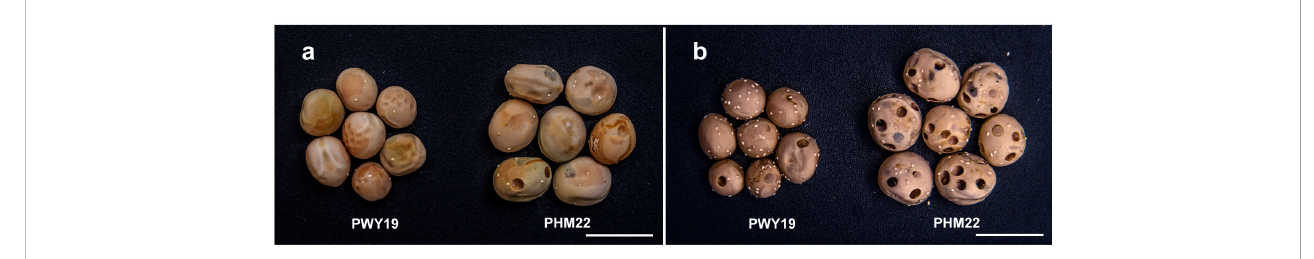
FIGURE 1 Phenotypic differences between PWY19 and PHM22 infested by C chinensis (A) and C maculatus (B) . Scale bars = 1